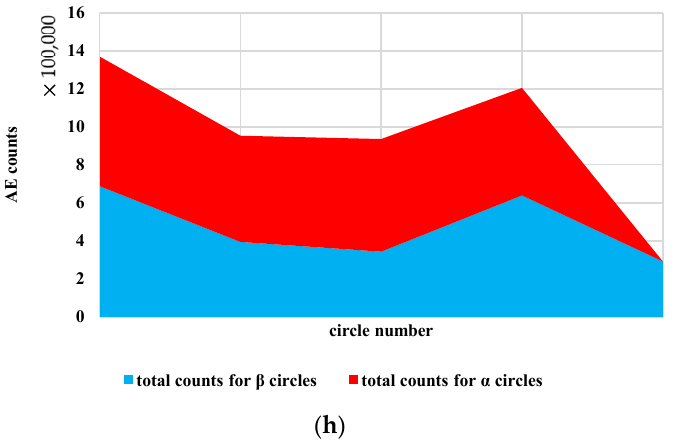
Figure 11. Area graphs showing the accumulated AE counts produced in each circle for fatigue tests with intervals of ( a ) 5 s, ( b ) 10 s, ( c ) 30 s, ( d ) 60 s, ( e ) 120 s, ( f ) 600 s, ( g ) 900 s, and ( h ) 1200 s. In order to discuss the influence of the fatigue intervals in more detail, we define: